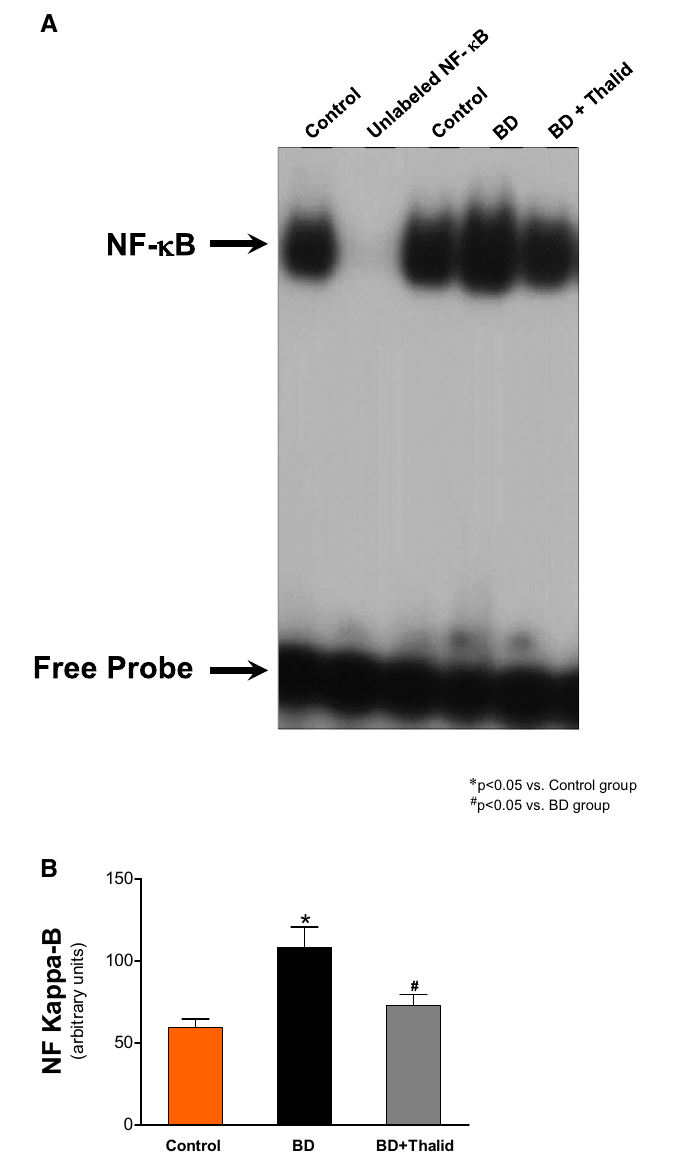
Figure 5. The results represent the effects of thalidomide on NF-κB activation in the liver in a rat donor brain death model. ( A ) Nuclear proteins were extracted from the liver of rats treated with thalidomide (BD + Thalid) (200 mg/kg), the control group and the brain death group (BD). Nuclear proteins (10 µg) were used to perform EMSA to evaluate NF-κB activity. Competition studies were performed using 10 µg of nuclear extract from the control group in the presence of 20-fold molar excess unlabelled specific NF-κB consensus sequence. ( B ) Densiometric analysis (arbitrary units, A.U.) of the NF-κB band is shown in Panel B. The composition of the specific NF-κB/DNA binding complex and the free probe is indicated. The results are expressed as the means ± SEM from 3 individual experiments. * p < 0.01 BD versus Control (n = 4); # p < 0.05 BD + Thalid versus BD (n = 4) (one-way ANOVA followed by Newman–Keuls test). The raw pictures of the EMSA are shown in Supplementary Fig.